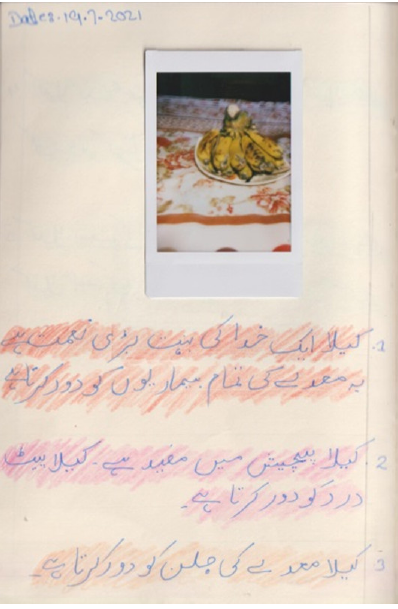
Figure 4. Jannat’s photodiary: “banana is a blessing of God, it can treat all stomach related issues. It is also helpful in dysentery. It cures stomach pain. It treats stomach acidity. [continues on another page, not shown] It cures dyspepsia and nausea. It is also beneficial in heartburn, and it also increases immunity.”.